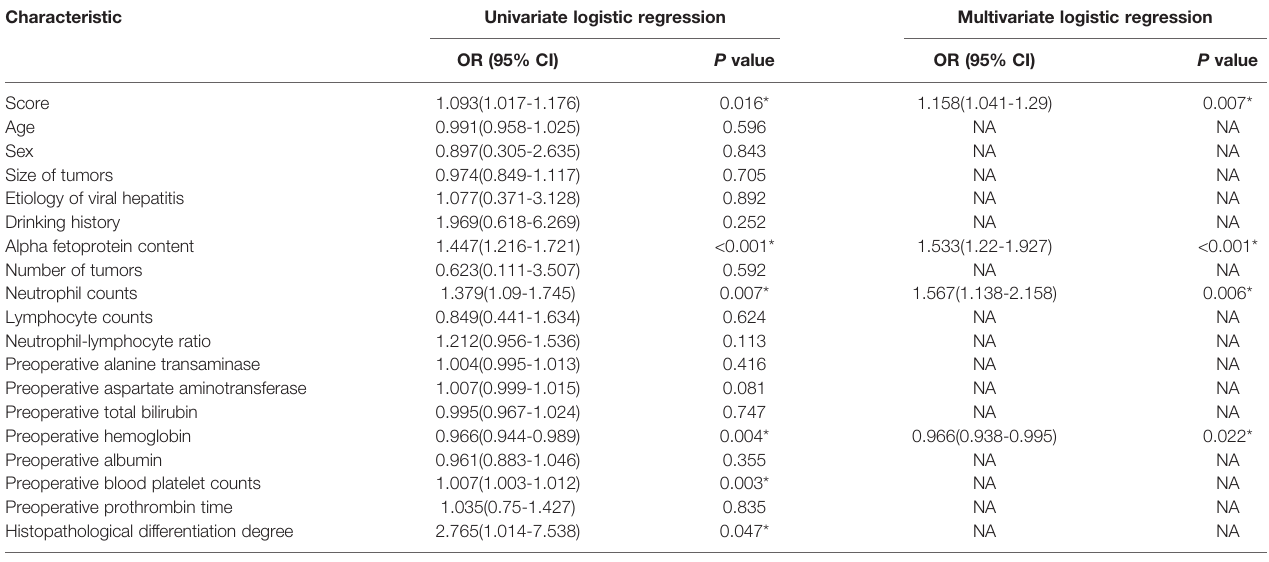
TABLE 3 | Risk factors for the diagnosis of tumors with microvascular invasion. Characteristic